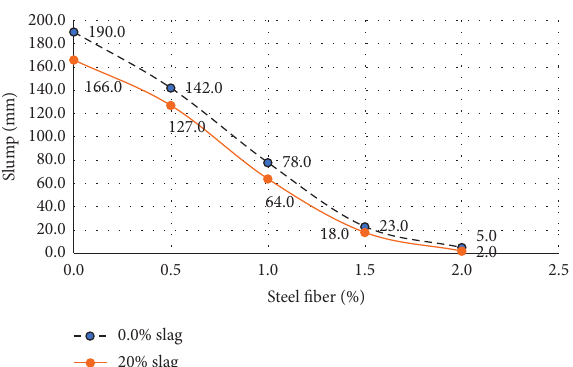
Figure 3: Results of flexural strength test with 0% and 20% slag at different concentrations of